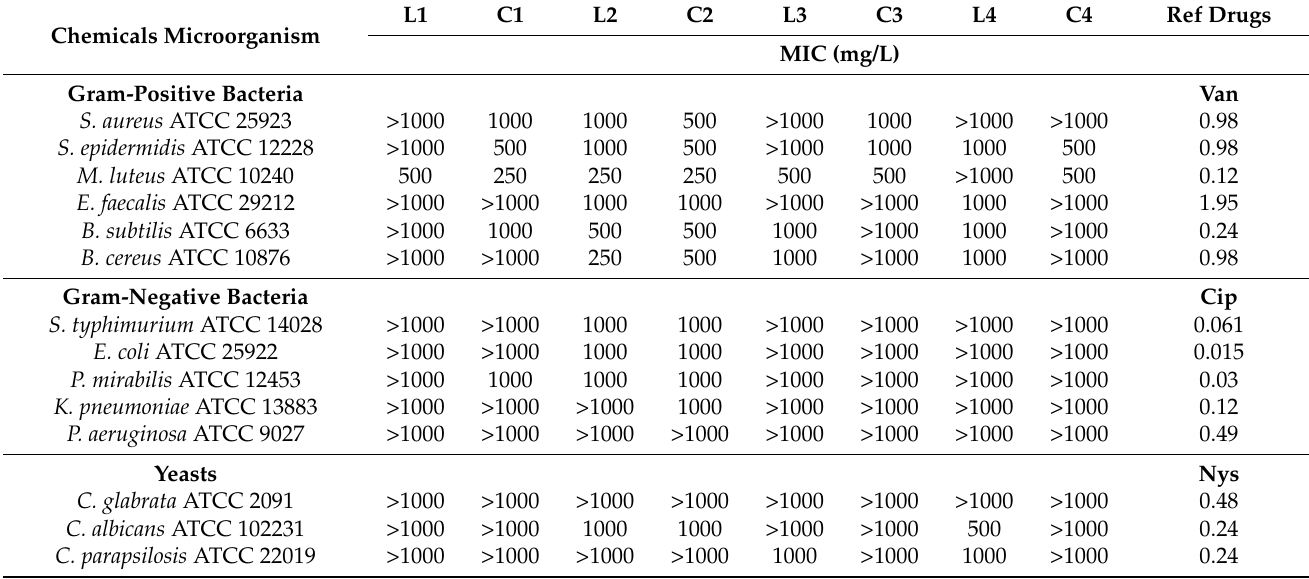
Table 3. In vitro antimicrobial activity of ligands and complexes